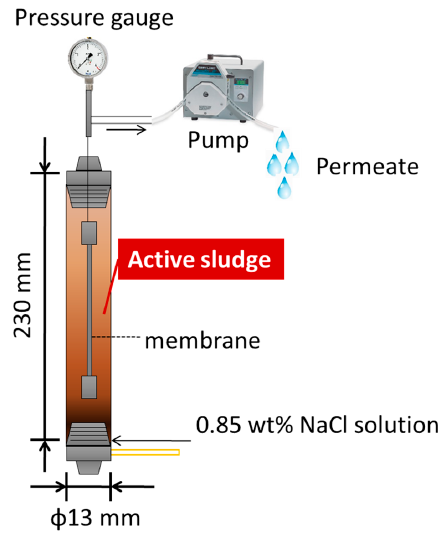
Figure 1. Schematic diagram of the experimental apparatus used in lab ‐ scale batch filtration test.